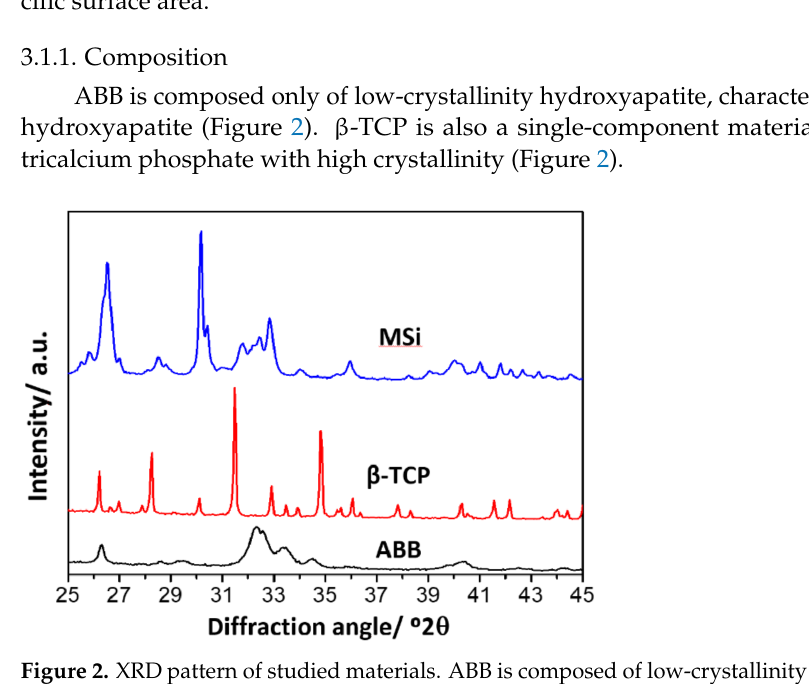
Figure 2. XRD pattern of studied materials. ABB is composed of low-crystallinity hydroxyapatite and β -TCP of pure β -tricalcium phosphate. MSi contains Zn-substituted monetite and hydroxyapatite as crystalline phases. It also contains amorphous calcium phosphate and hydrated silica gel